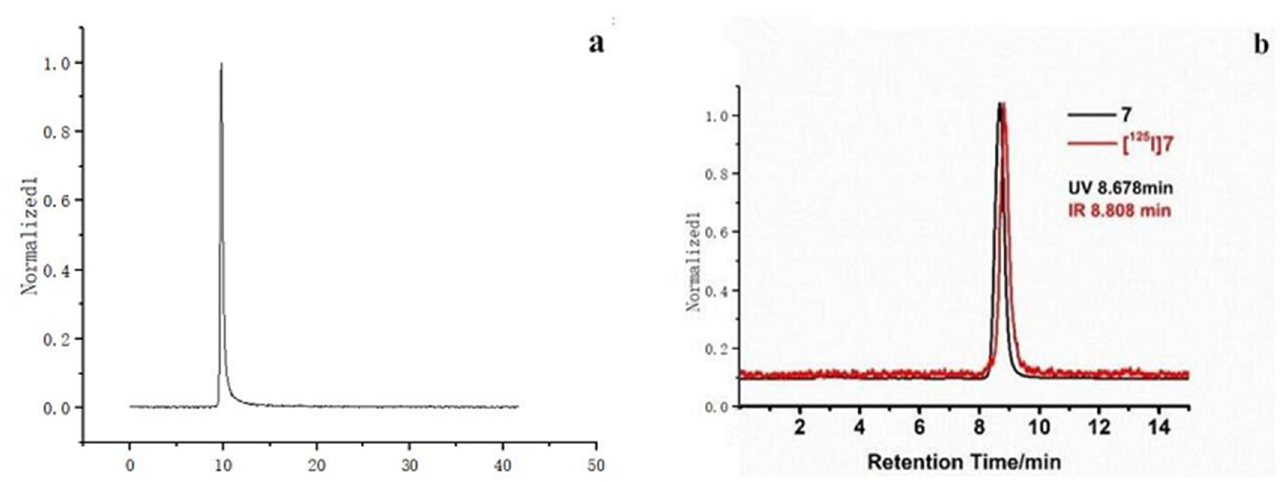
Figure 3. HPLC chromatograms ( a ). The HPLC of 125 I-PSMA-7. ( b ). The HPLC of a mixture of Compound 7 and 125 I-PSMA-7.